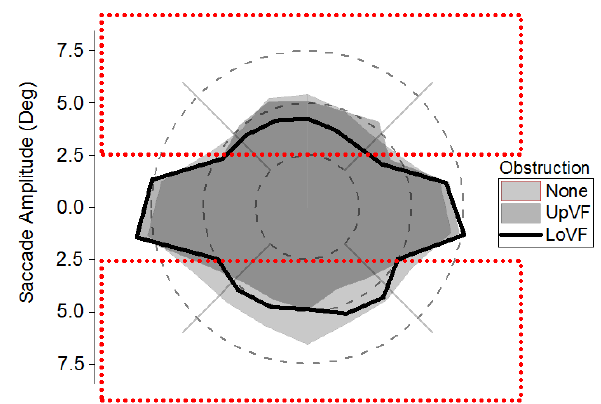
Figure 3 : Saccade amplitudes as a function of saccade direction and obstruction condition. The rectangles show visual field obstruction locations in the upper or lower visual field, relative to eye fixation (i.e. 0 deg). Vertical saccades were executed beyond the 2.5 deg near boundaries of obstruction .